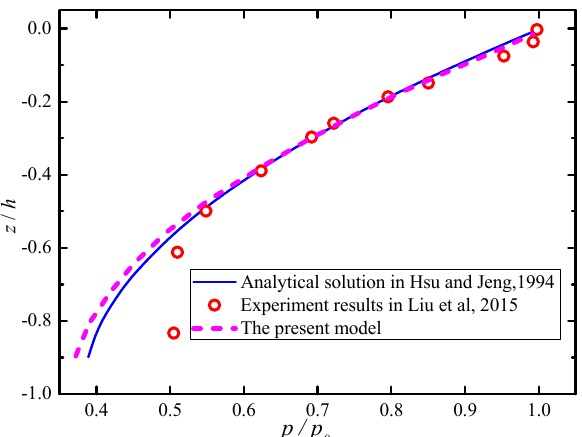
( ) / pp 0 s versus the seabed depth